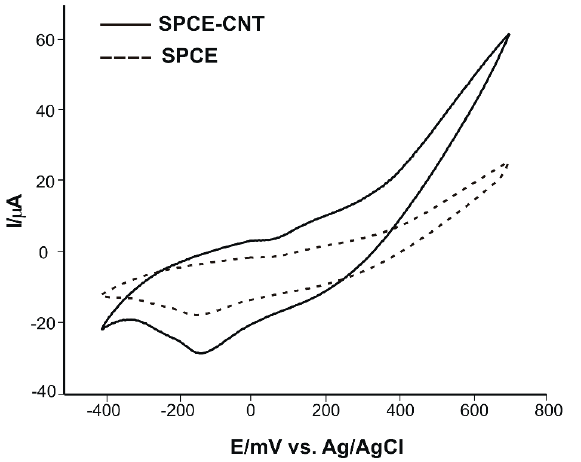
Figure 3. Cyclic voltammograms of the SPCE-CNT (solid line) and SPCE (dashed line) immersed in a 0.001 M catechol solution registered with a scan rate of 0.1 V·s − 1 .